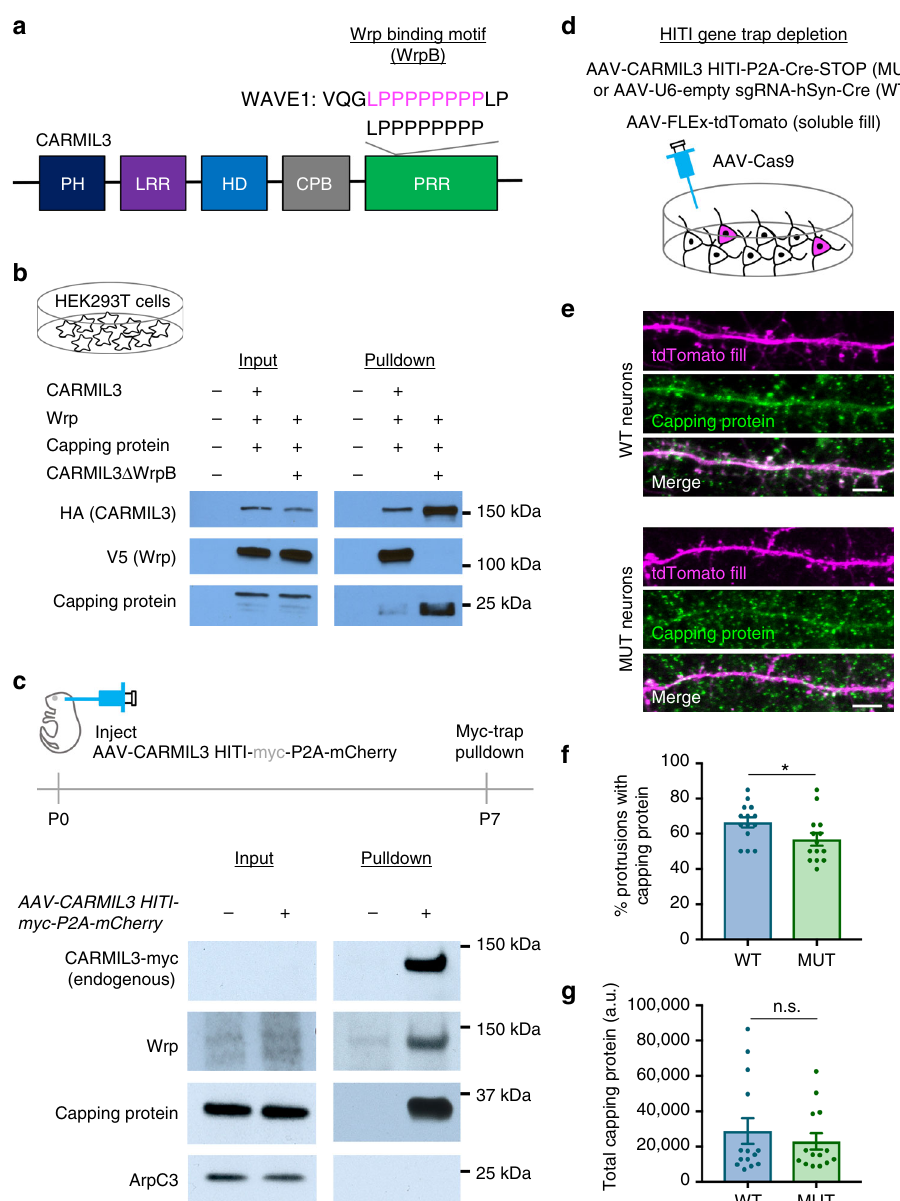
Fig. 7 CARMIL3 interacts with both Wrp and capping protein in developing synapses. a Schematic depicting domains of CARMIL3. PH pleckstrin homology domain, LRR leucine-rich region, HD helical domain, CPB capping protein-binding domain, PRR proline-rich region. The beginning of the PRR also contains a region with homology to the Wrp-binding motif (WrpB) of WAVE1. b Pulldowns of HA epitope-tagged CARMIL3 or CARMIL3 with a deletion of the 8 amino acid Wrp-binding motif. CARMIL3, Wrp, and capping protein constructs were overexpressed in HEK293T cells. c Pulldowns of endogenous CARMIL3 with HITI epitope-tagged Myc on the c-terminus. Both Wrp and capping protein, but not ArpC3 co-IP with CARMIL3 in vivo in the mouse forebrain. d Schematic depicting CRISPR depletion of CARMIL3 in cultured hippocampal neurons. e Representative images of WT and MUT neurons at DIV16 stained for capping protein (green) and tdTomato fi ll (magenta). Scale bars are 5 μ m. f Graphical representation of the percentage of dendritic protrusions with capping protein for WT (66 ± 3%, n = 14 neurons) and MUT (57 ± 4%, n = 14 neurons) neurons at DIV16. p = 0.0473. g Graphical representation of the total amount of capping protein in WT (28823.00 ± 7271.45 a.u., n = 14 neurons) and MUT (22943.41 ± 4640.35 a.u., n = 14 neurons) dendrites at DIV16. Error bars are standard error of the mean (SEM). p = 0.5026. * p <0.05, t